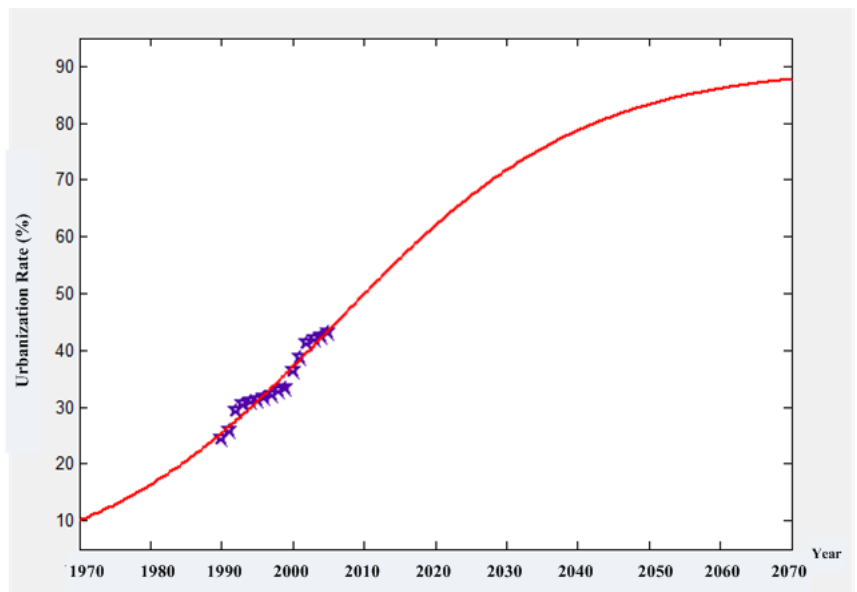
Figure 11. Fitting result of urbanization rate with the logistic curve